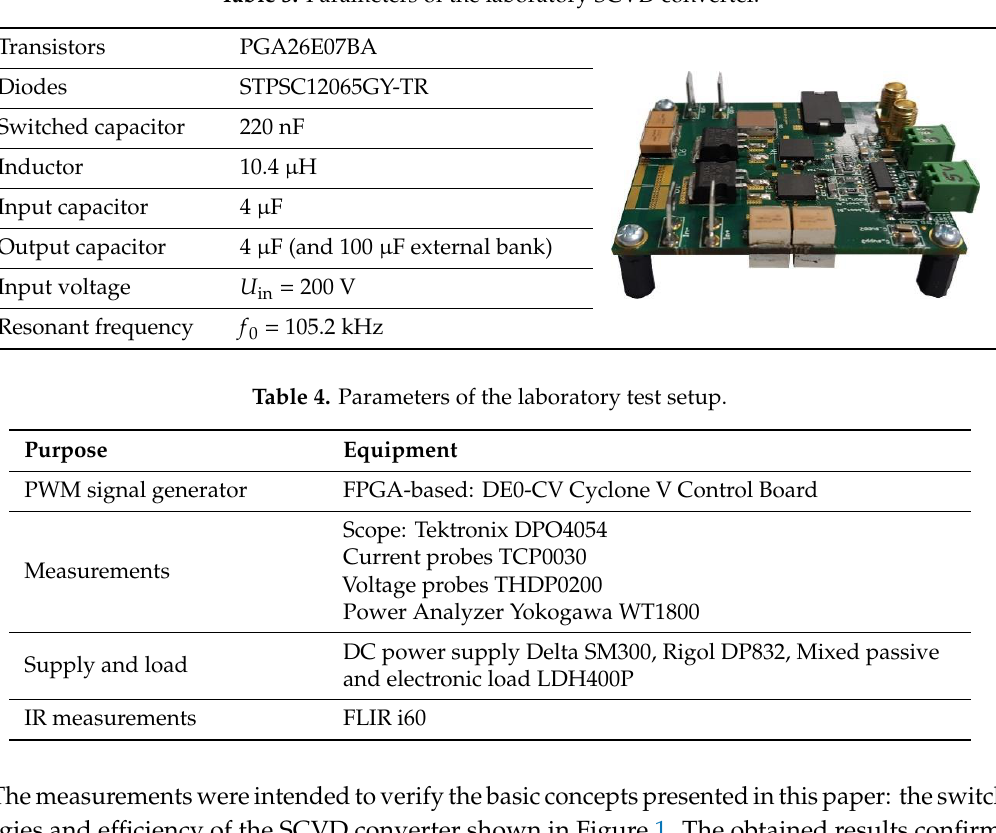
Table 3. Parameters of the laboratory SCVD converter.